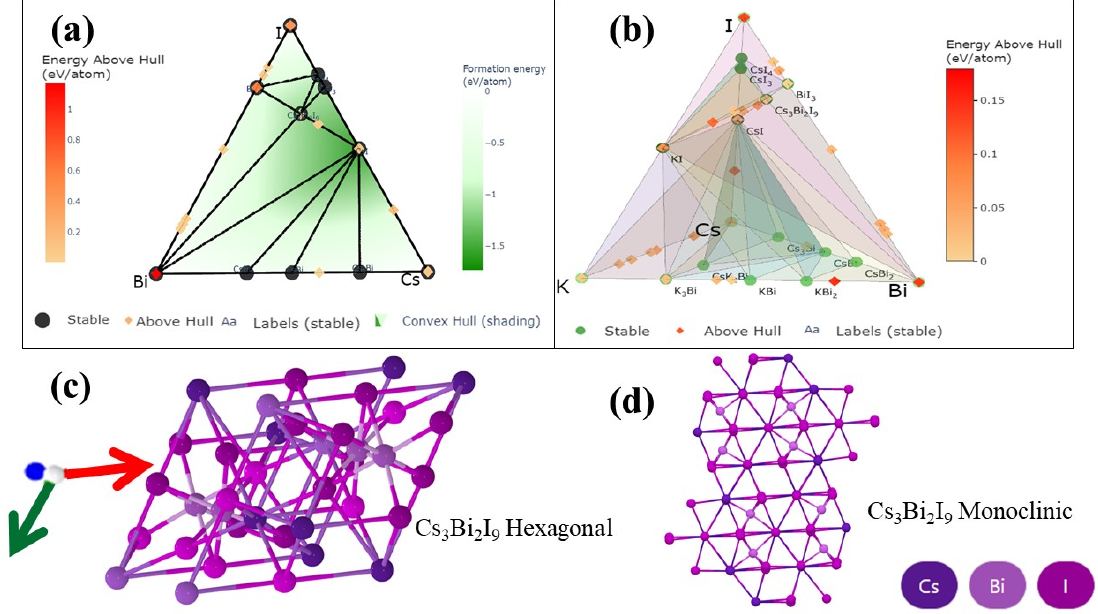
Figure 2. ( a ) Phase diagram of the Cs-Bi-I ternary system. ( b ) Phase diagram of the Cs-Bi-I-K quaternary system. ( c ) Crystal structures of the three-dimensional perovskite P 6 3 /mmc Cs 3 Bi 2 I 9 . ( d ) Crystal structures of the three-dimensional perovskite C2/c Cs ₃ Bi ₂ I ₉ . Figure 2a,b show the three-dimensional structure of Cs 3 Bi 2 I 9 perovskite Table 1. Lattice structures and calculated bandgaps of Cs ₃ Bi ₂ I ₉ for the P6 ₃ /mmc, C2/c, and Fm-3m structures.